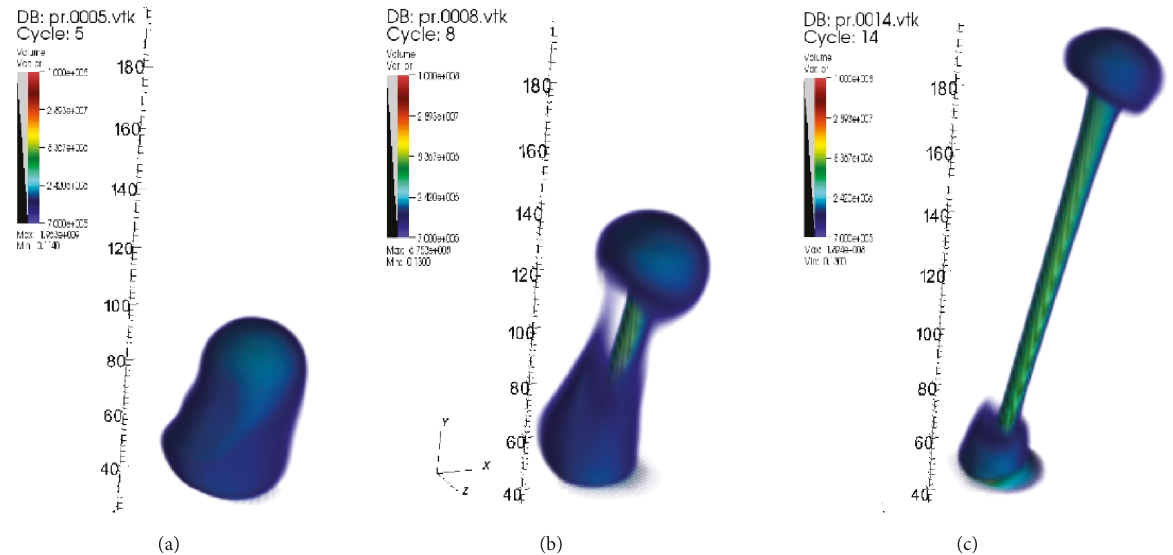
Figure 6: Scenario D: the pressure evolution for the model jet of run4. This plot is similar to the one for the jet density. The patterns are similar to those of the density for the same run. The higher jet’s density dominates the system dynamics, leading to comparatively poorer features around the jet, in relation to other runs where the jet was lighter. The pressure distribution follows the above general pattern. A pressure increase is also seen around the jet base, due to the mass leftover from the disturbed accretion disk wind that used to be there (run4 parameters in Table